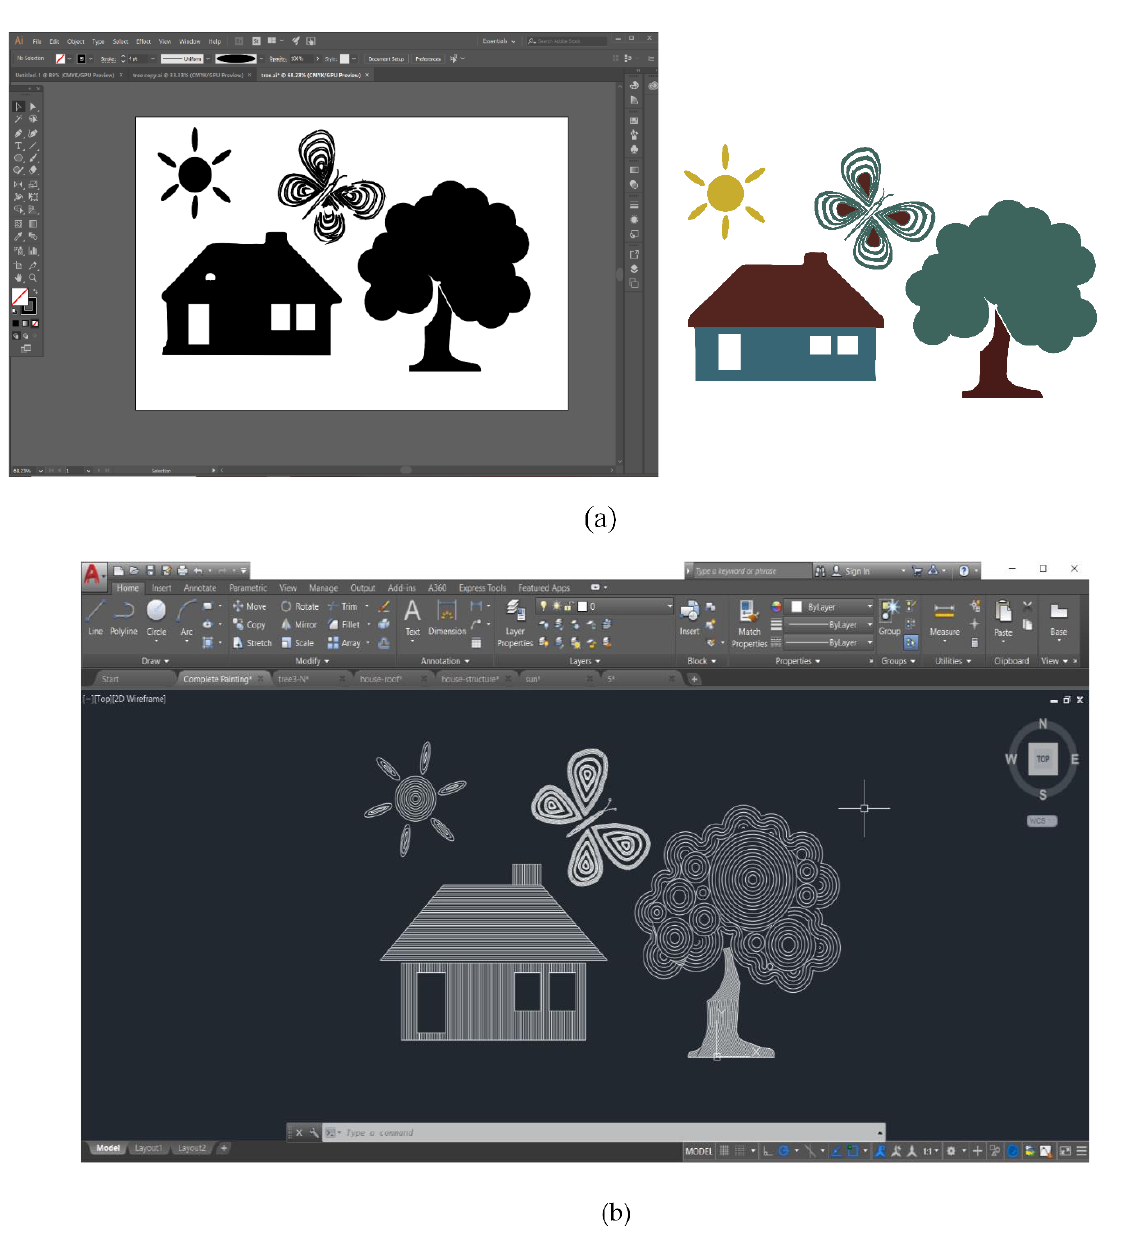
Figure 5. ( a ) First illustration of drawing in Adobe Illustrator. ( b ) Imported drawing (.dxf file) in AutoCAD to export file for laser software.